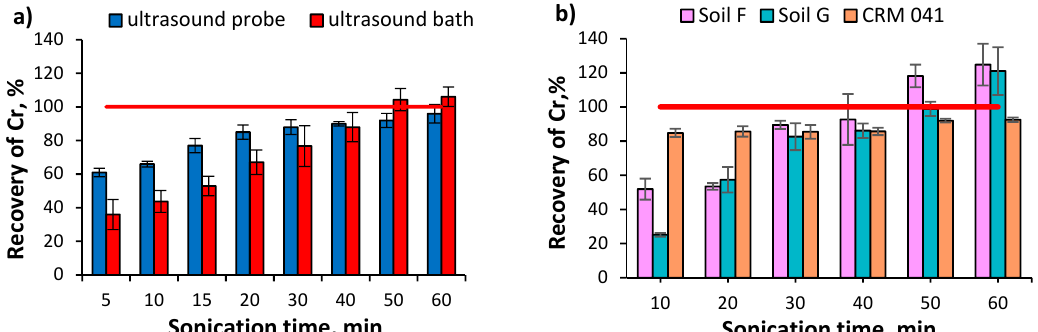
Figure 1. The influence of the sonication time on the recovery of Cr in alkaline extract of ( a ) organic soil spiked with BaCrO 4 obtained by an ultrasound-assisted procedure using ultrasound probe (power: 26 W) and ultrasound bath (power: 100%); ( b ) natural organic soil (F,G) and CRM 041 obtained by an ultrasound assisted procedure using ultrasound bath (power: 100%) in comparison to results obtained by a classical procedure or certified value.